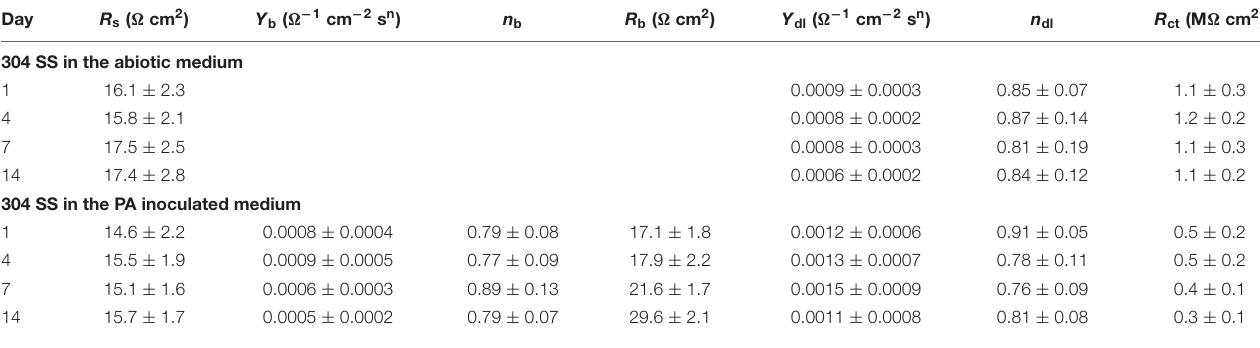
TABLE 1 | Electrochemical impedance spectroscopy (EIS) parameters of coupons obtained on four different days during the 14 days of incubation (standard deviations from 3 independent samples).